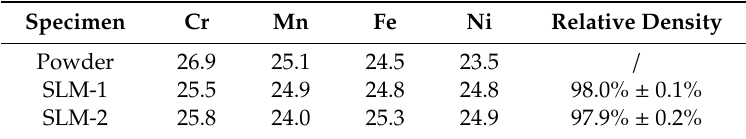
Table 1. Relative density and chemical composition (in at%) of selective laser melting (SLM) CrFeNiMn alloy specimens. Chemical composition (in at%) of CrFeNiMn powder.